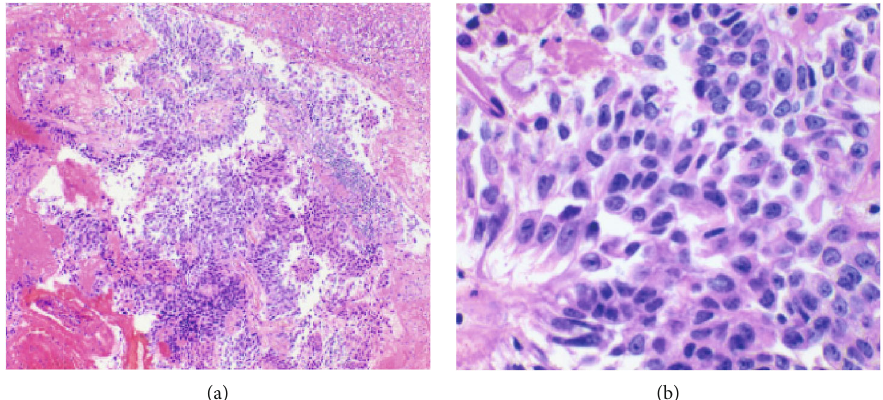
Figure 1: (a) Papillary urothelial carcinoma fragments; cell block (H&E, medium power 10x). (b) High-grade cytologic atypia with enlarged hyperchromatic nuclei and high N/C ratio; cell block (H&E, high power 40x).